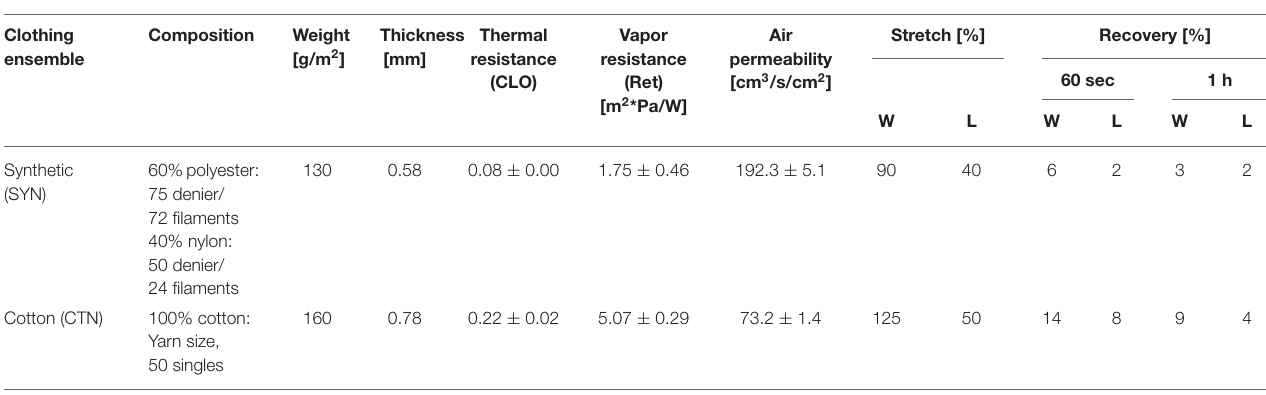
TABLE 2 | Clothing ensembles